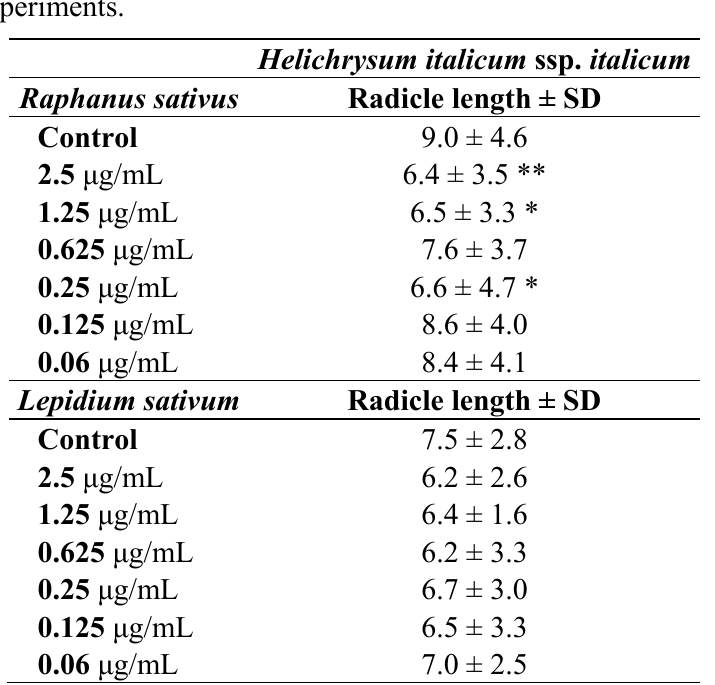
Table 3. Biological activity of essential oil of Helichrysum italicum spp. italicum against radicle elongation of Raphanus sativus (radish) and Lepidium sativum (garden cress), 120 h after sowing. Data are expressed in cm. Results are the mean ± standard deviation (SD) of three